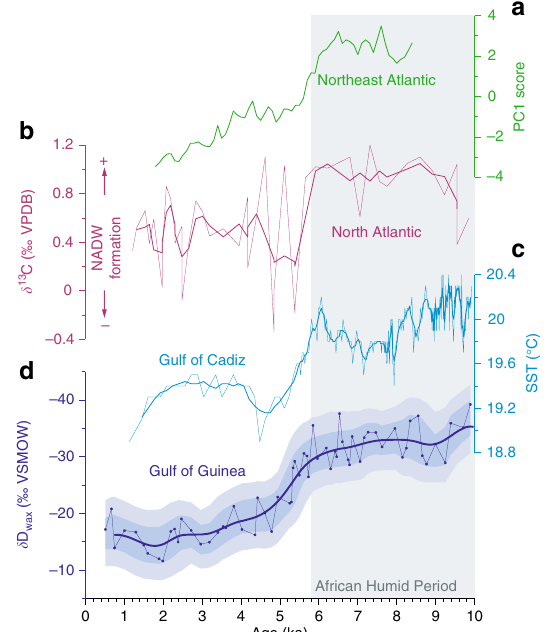
Fig. 6 Comparison with mid- and high-latitude records. a Principle Component 1 (PC1) scores from eight alkenone SST records in the northern Atlantic (Supplementary Table 1). PC1 represents 57.8% of the variance. b δ 13 C of benthic foraminfera from core EN120-GGC1 in the north Atlantic, interpreted as a record of NADW formation and ocean circulation: lower values represent slower ocean circulation 54 . c Alkenone SST from core GeoB5901-2 in the Gulf of Cadiz, just to the north of Africa 87 . d δ D wax from GeoB4905-4 (ice-volume and vegetation adjusted, this study). Shadings indicate 68 and 95% uncertainty bounds, including analytical and